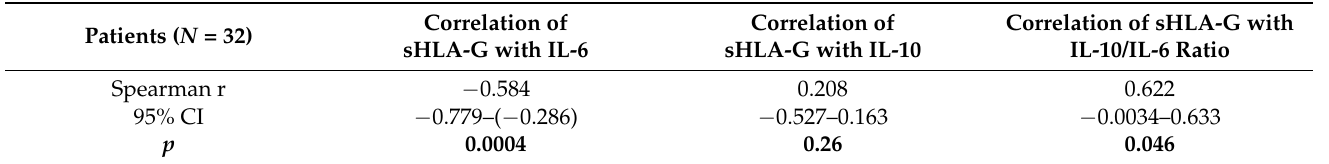
Table 7. Correlation of plasma levels of sHLA-G with IL-6, IL-10 levels, and IL-10/IL-6 in glioma